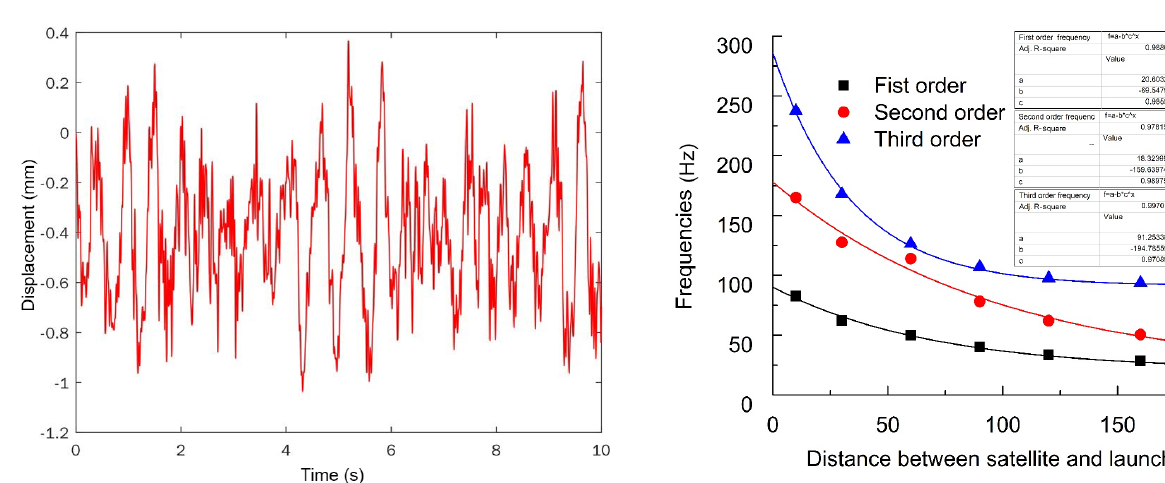
Figure 13. Displacement response of the satellite relative to the fairing.